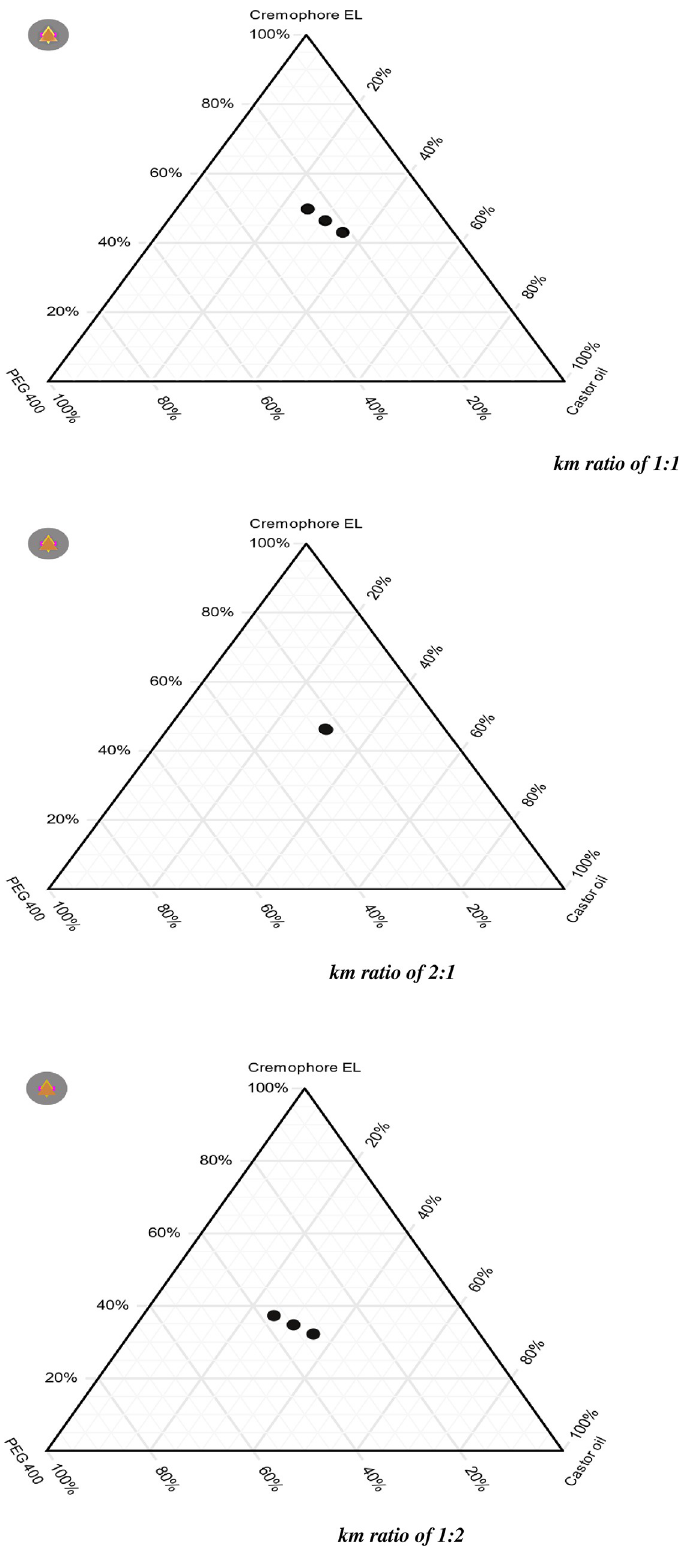
Fig 8. Tertiary phase diagram for determining the emulsion region of the SNEDDS.